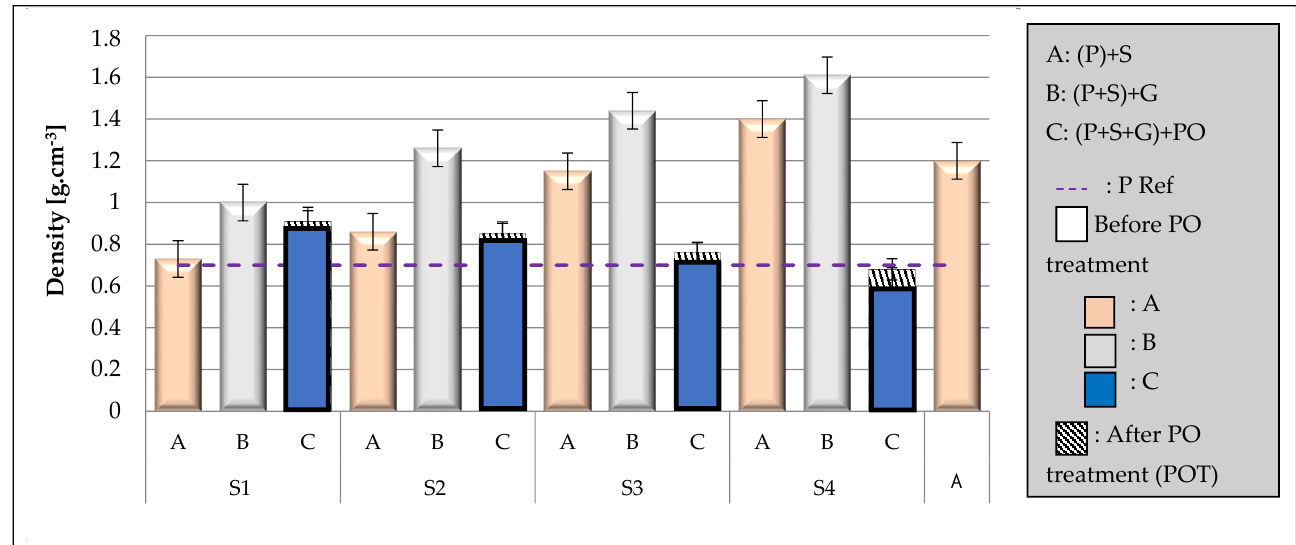
Figure 10. Variation in density of composites in the different mixing plans.